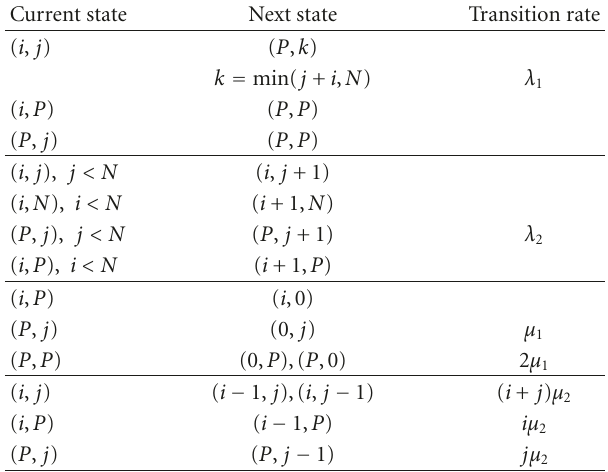
Table 2: Transition rates in system 3b with M =